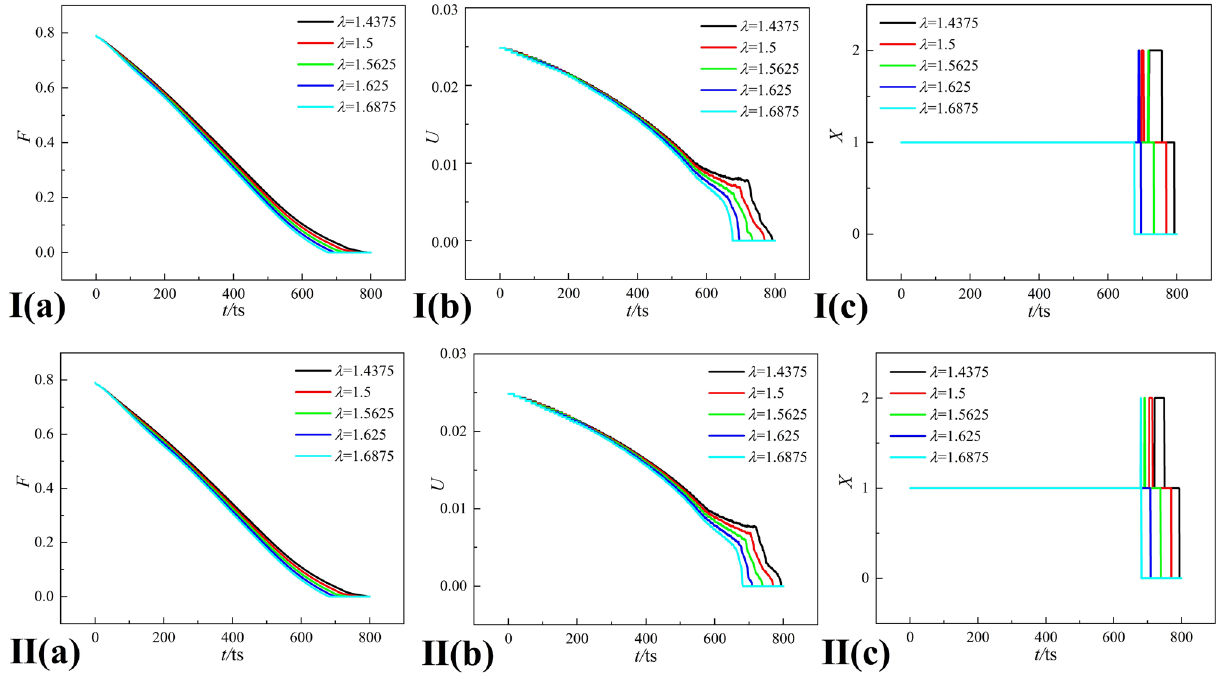
Figure 15. Morphological analysis of the collapsing bubble under different offset parameters (I: = D 1.03325 and II: = D 1.03476 ; ( a ) fractional area F , ( b ) boundary length U , and ( c ) Euler characteristic X